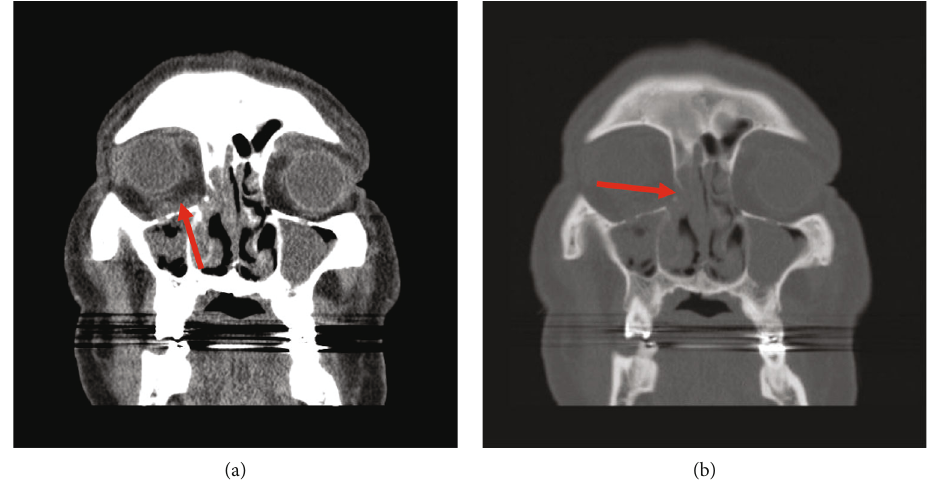
Figure 6: Coronal paranasal CT images without contrast administration. Soft tissue window images: (a) area of increased density in the inferior aspect of right orbit suggestive of orbital in fl ammation. Mucosal thickening in the right maxillary sinus and a retention cyst in the Lt maxillary sinus was also demonstrated. Bone window image: (b) thinning in the medial aspect of the inferior orbital wall at the right side, suggestive of a small bony erosion (compared to the Lt